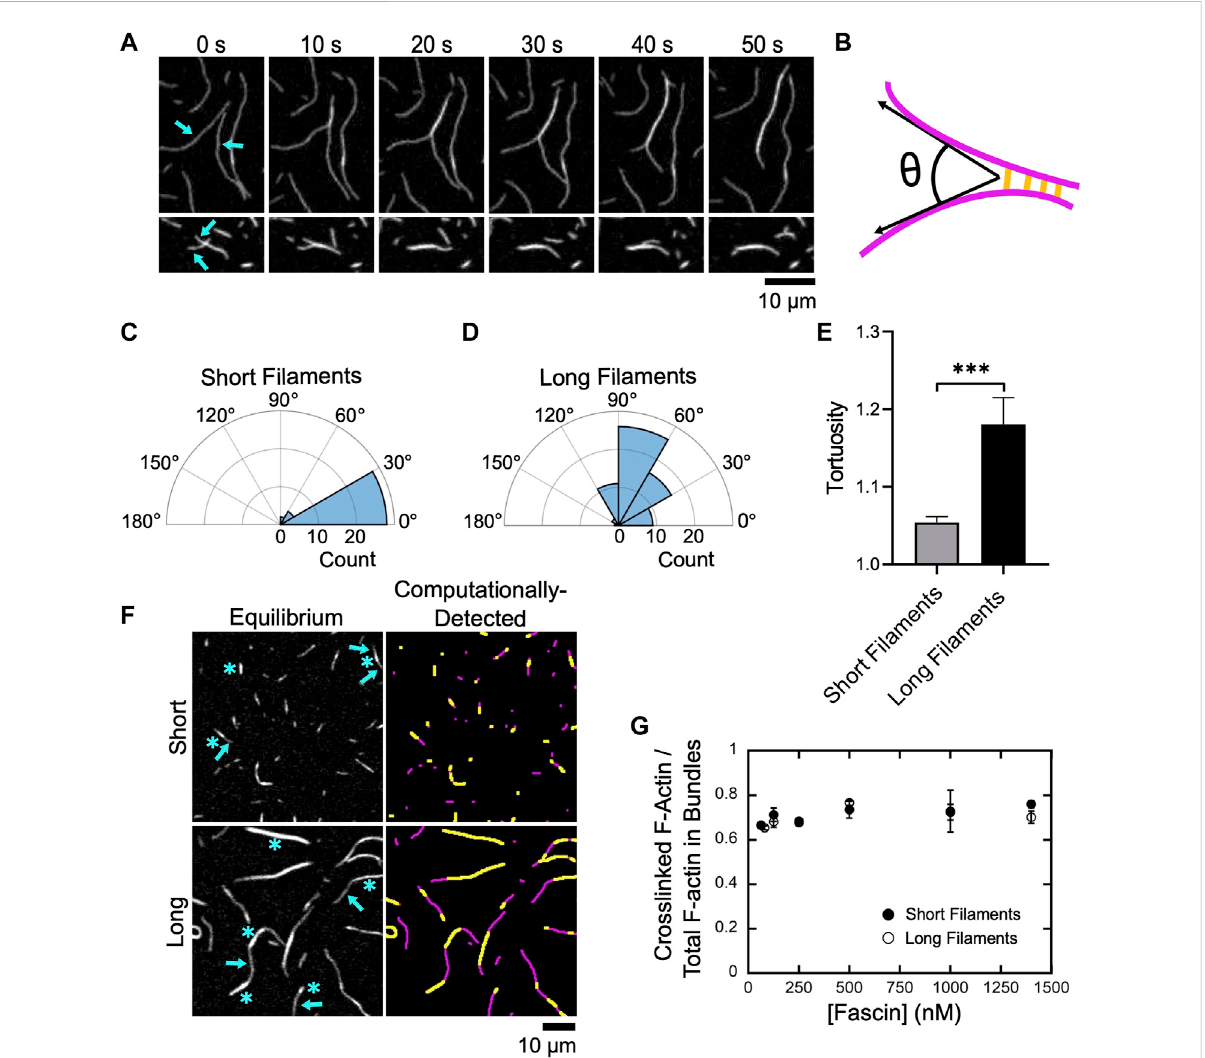
FIGURE 2 Fascin bundles short and long fi laments cooperatively. Filaments were assembled by Cdc12p (short fi laments) or via spontaneous actin polymerization (long fi laments), labeled with FITC-phalloidin, diluted into microscopy buffer and imaged using TIRF microscopy following the introduction of fascin. (A) Representative time series of TIRF micrographs showing bundling of two long fi laments (upper panels) and two short fi laments (lower panels) in the presence of 1,000 nM fascin. (B) Schematic depicting the angle of alignment ( θ ) de fi ned by two fi laments (magenta) as they undergo bundling by fascin (yellow). (C,D) Polar histograms of angles of alignment measured for short (C) and long fi laments (D) during the formation of new bundles. Angle measurements were obtained for at least 30 bundling events from three independent replicates. (E) Tortuosity (de fi ned as the ratio of the contour length to the end-to-end distance) of actin bundles assembled from short and long fi laments (n ≥ 40bundlesfromatleastthreeindependentreplicates).Statisticalsigni fi cancewasestablishedusingWelch ’ s t -test(*** correspondsto p < 0.001). (F) Micrographs (left column) and computational detection (right column) of bundles of short and long actin fi laments at equilibrium. Bundles contain crosslinkedregions(blueasterisksinleftpanels,yellowstretchesinrightpanels)andstretchesofsingle fi laments(bluearrowsinleftpanels,magenta stretches in right panels). (G) Dependence of the ratio of the fl uorescence intensity of crosslinked regions to the total fl uorescence intensity of the fi lamentous actin contained in bundles on the concentration of fascin for short (closed circles) and long (open circles) fi laments. Error bars are the standard error of the mean from at least three independent